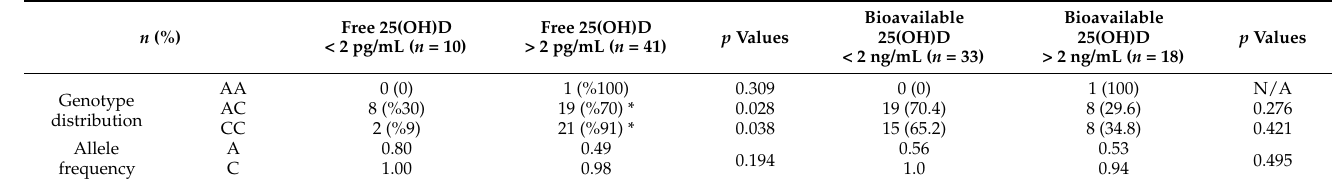
Table 4. Genotype distributions and allele frequencies of individuals with rs4588 polymorphism, grouped according to free and bioavailable 25(OH)D